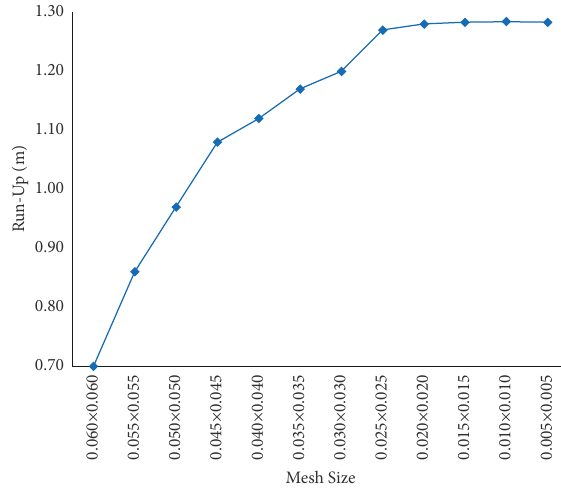
Figure 6: Sensitivity analysis of the model mesh size.